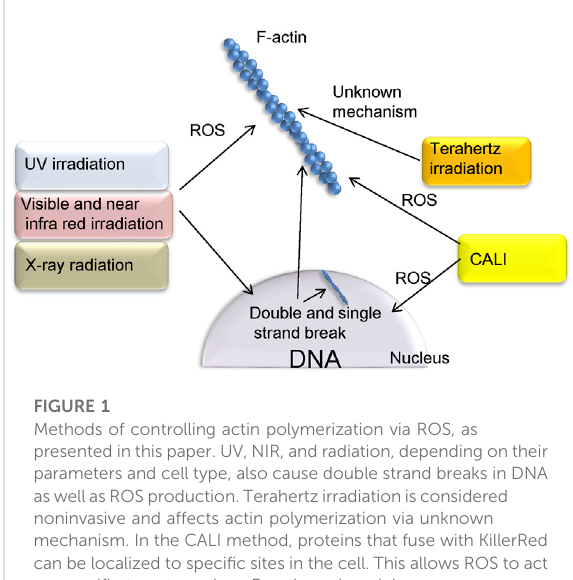
FIGURE 1 Methods of controlling actin polymerization via ROS, as presented in this paper. UV, NIR, and radiation, depending on their parameters and cell type, also cause double strand breaks in DNA aswellas ROSproduction.Terahertzirradiationisconsidered noninvasive and affects actin polymerization via unknown mechanism. In the CALI method, proteins that fuse with KillerRed can be localized to speci fi c sites in the cell. This allows ROS to act on speci fi c targets such as F-actin and